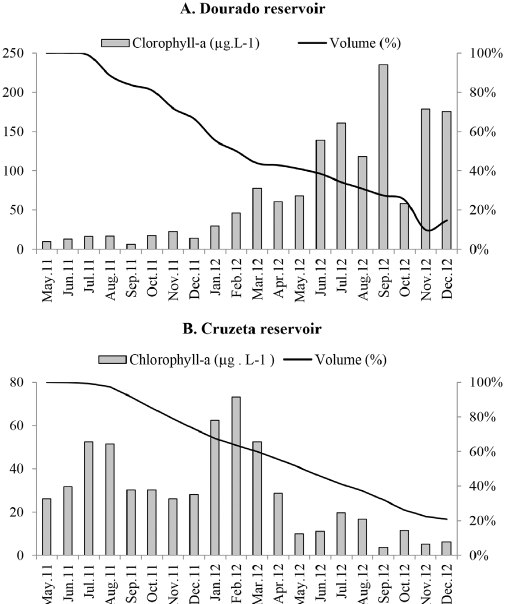
Figure 4. Secchi transparency in Dourado (grey bars) and Cruzeta (white bars) reservoirs during the study period.